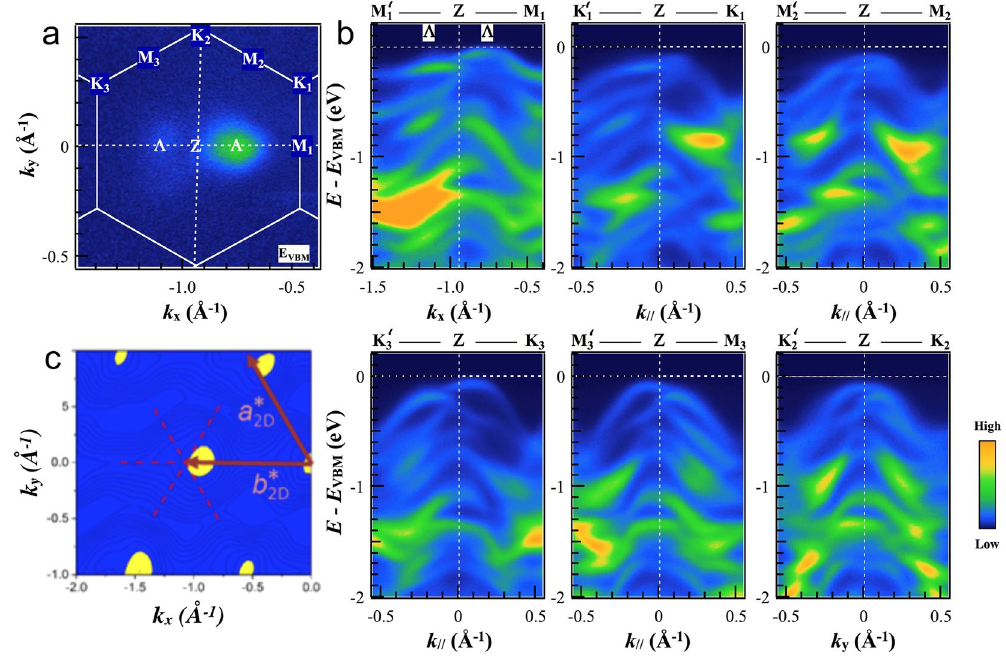
Figure 3. Electronic band structure of ReSe 2 ( a ) ARPES constant energy plots measured with 100 eV photon energy throughout the reciprocal unit ReSe 2 cell. Experimental photoemission signal as a function of in-plane momentum at an energy close to the VBM for a section through the Brillouin zone passing through the Z point, showing the special points of the quasi-Brillouin zone including the position of the local VBM (labelled Λ ) ( b ) ARPES data along the M’ZM and K’ZK directions in the reciprocal space. ( c ) DFT calculations of the density of states at the top of the valence band in the plane containing the Z point, in good agreement with experimental results shown in panel ( a